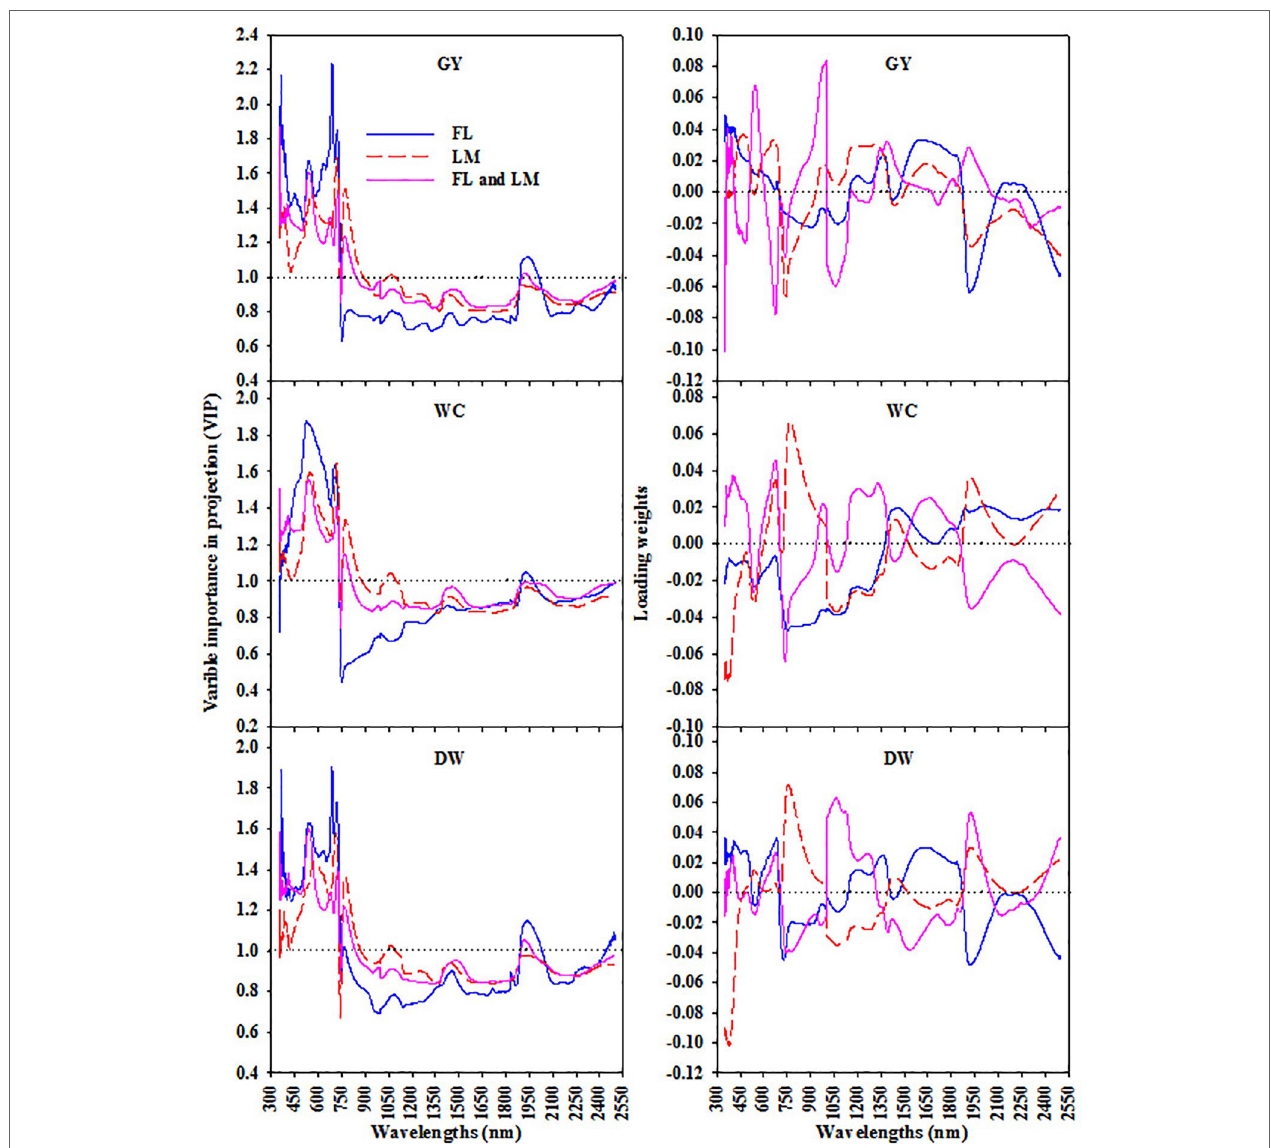
FIgURe 5 | The variable importance in projection (VIP) and loading weights of PLSR analysis over full wavelengths to extract the sensitive spectral band intervals for each measured parameters [shoot dry weight per square meter (DW), water content of aboveground biomass (WC), and grain yield per hectare (GY)] under full irrigation (FL), limited irrigation (LM), and the combined two treatments (FL+LM).